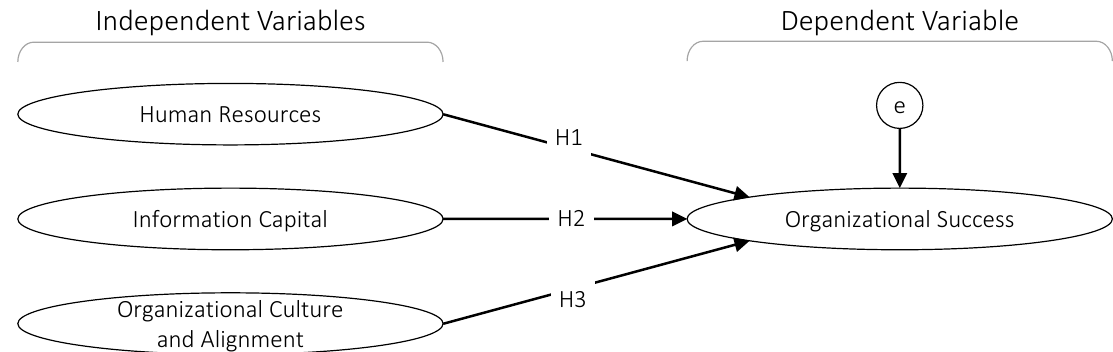
Organizational Culture and Figure 1. Hypothesized paths of the study model